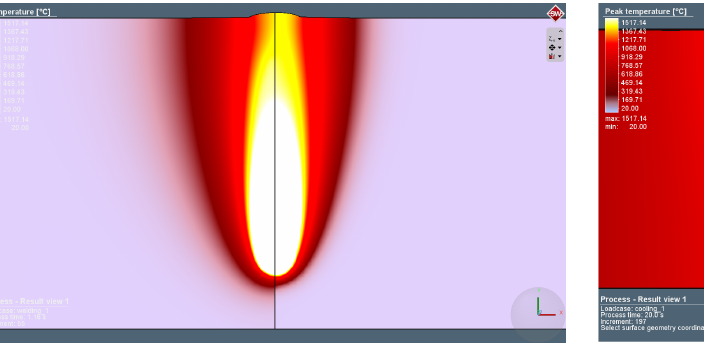
Figure 3: Dimensions of simulated dissimilar laser welded joint in cross section mericalsimulationwereusedinexperimentalweldingpro-